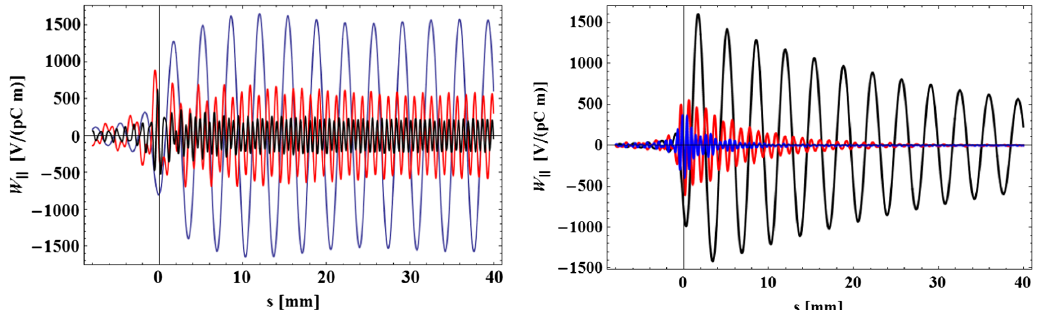
FIG. 6. Separated contributions of the first three resonances to the wake function: ε 00 1 ¼ 0 (left) and ε 00 1 ¼ 0 . 5 (right).